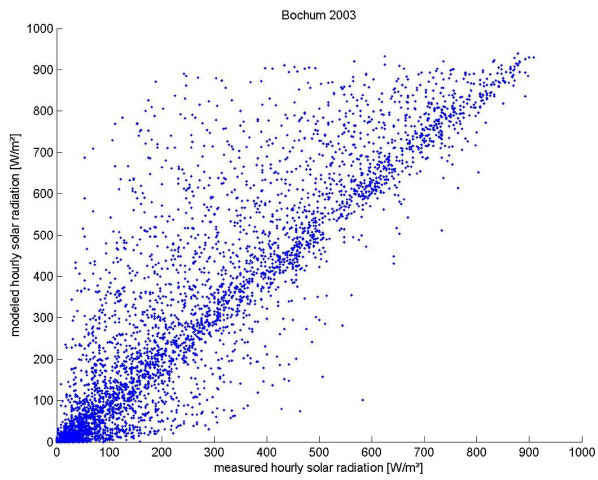
Figure 2. Scatterplot of modeled against measured data for one year of hourly data